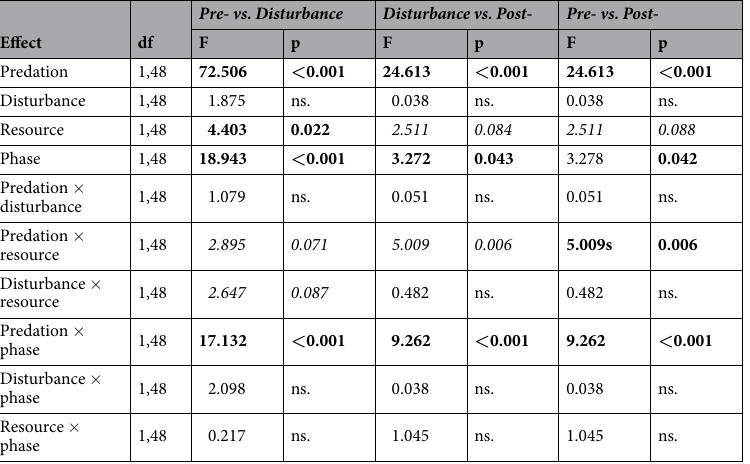
Table 3. Results of redundancy analysis. Df is degrees of freedom, F-statistics and p-values were derived from permutation tests. Significant effects are highlighted in bold and marginally significant effects (p < 0.1) in